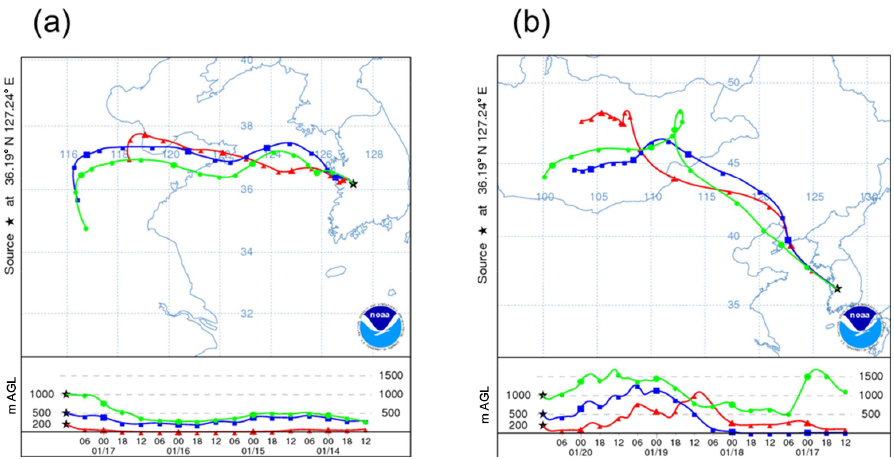
Figure 7. Air mass backward trajectories arriving at the measurement site on (a) 16 and (b) 20 January 2014. Red, blue, and green lines represent backward trajectories arriving at heights of 200, 500, and 1000m, respectively.